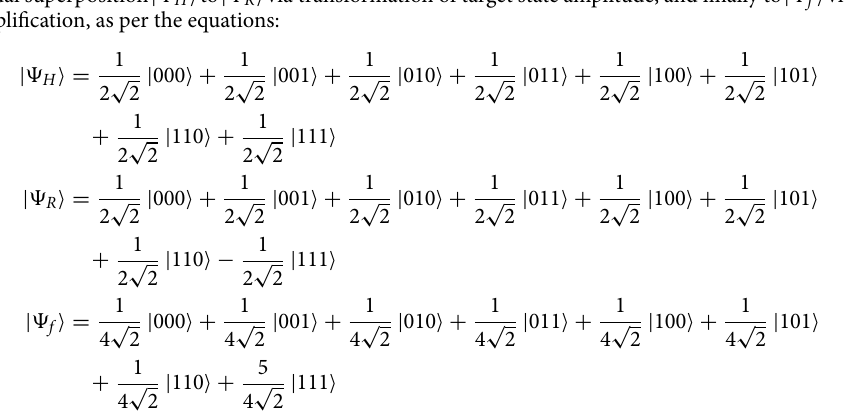
√ . Progressing to the right, the 2 2